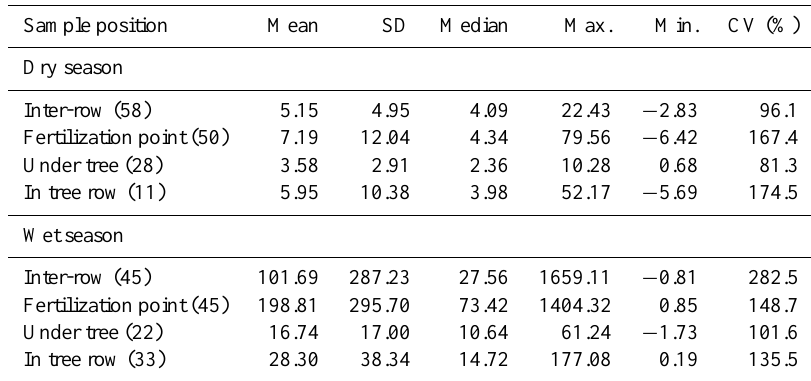
Table 3. Statistics for N 2 O fluxes during the dry and wet seasons. Sample